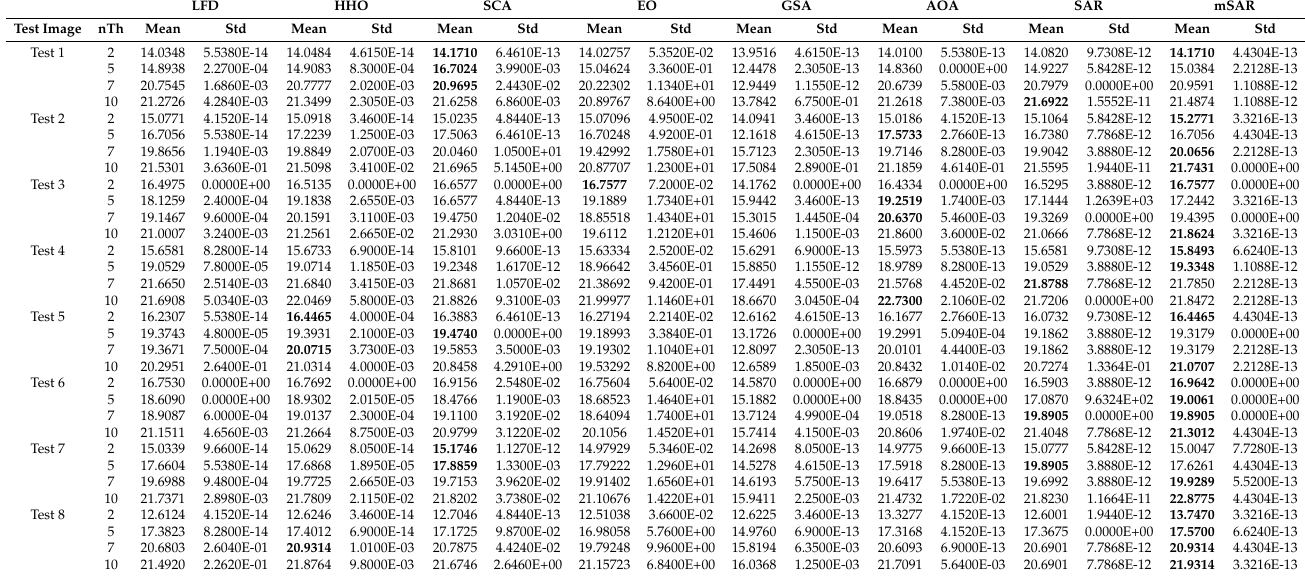
Table 5. mSAR fuzzy entropy in terms of PSNR values over all competed